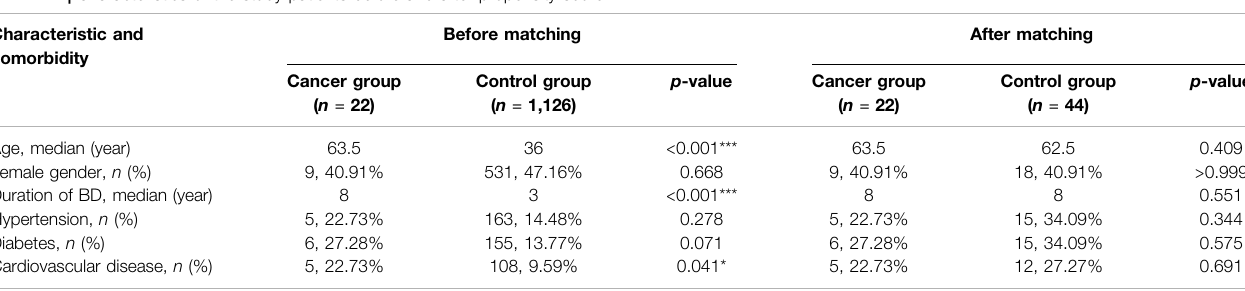
TABLE 1 | Characteristics of the study patients before and after propensity score. Characteristic and